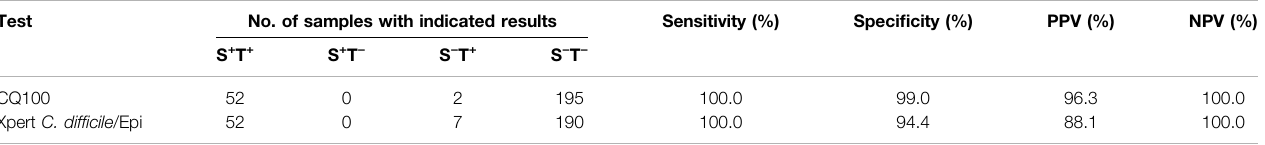
TABLE 2 | Sensitivity, speci fi city, and predictive values of the two assays for toxigenic C. dif fi cile detection. Test No. of samples with indicated results